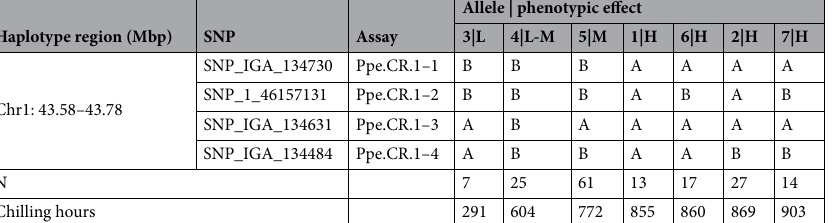
Haplotype region